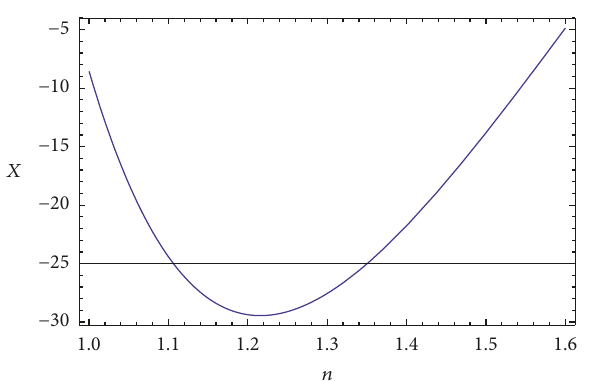
̈𝑆 tot by taking Bekenstein entropy as entropy